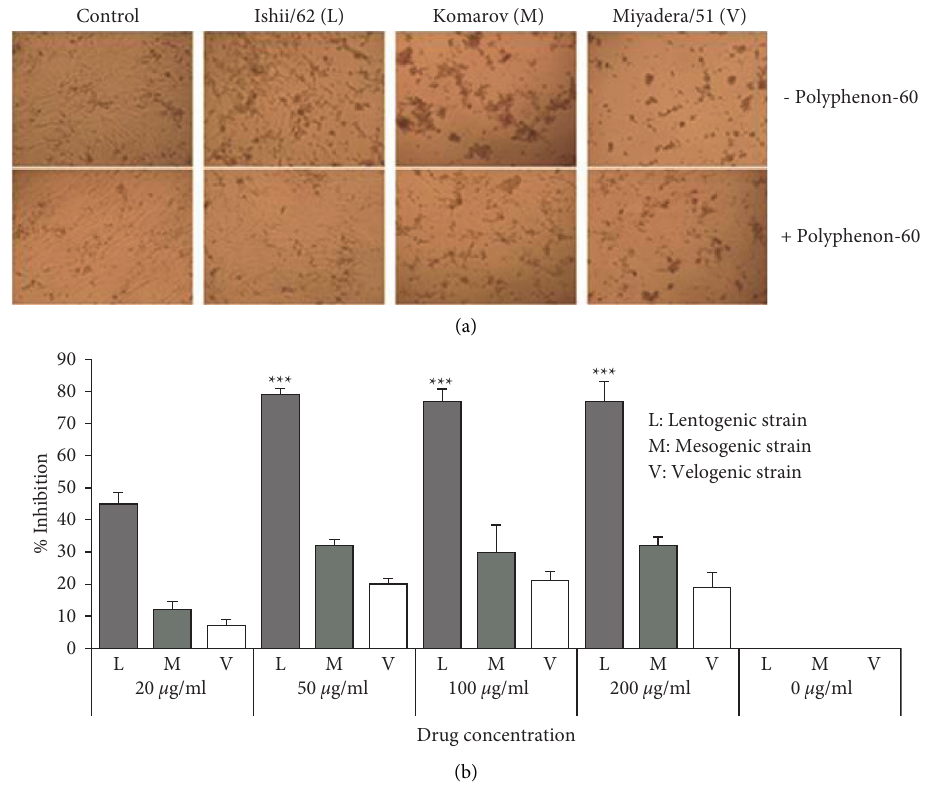
Figure 2: The inhibitory activity of polyphenon-60 on the infection of NDV. (a) The inhibitory activity of polyphenon-60 on cytopathic effects of NDV in CEF cells at 48h p.i. (b) The antiviral activity of polyphenon-60 against different NDV pathotypes. Data were expressed as the mean ± SD of three independent experiments and compared by using Student’s t -tests. ∗∗∗ Highly statistically significant ( p < 0 . 001). Table 2: Inhibitory effect of polyphenon-60 on the growth of NDV strains in chicken embryonated eggs. NDV